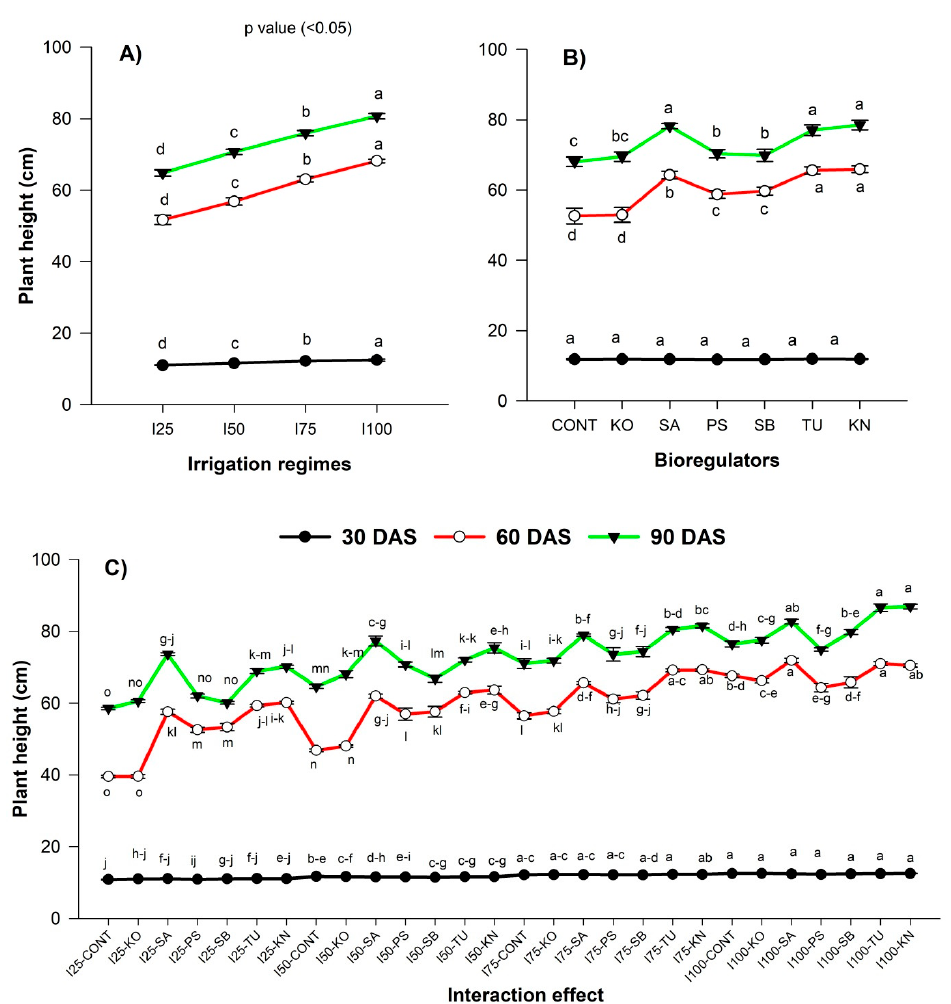
Figure 2. Effect of irrigation level ( A ), BR ( B ), and interaction effect ( C ) on plant height of chia at various growth stages. KO, SA, PS, SB, TU, KN, and no BR denote kaolin, salicylic acid, potassium silicate, sodium benzoate, thiourea, potassium nitrate, and control, respectively, while BRs and CPE denote bioregulators and cumulative pan evaporation, respectively.